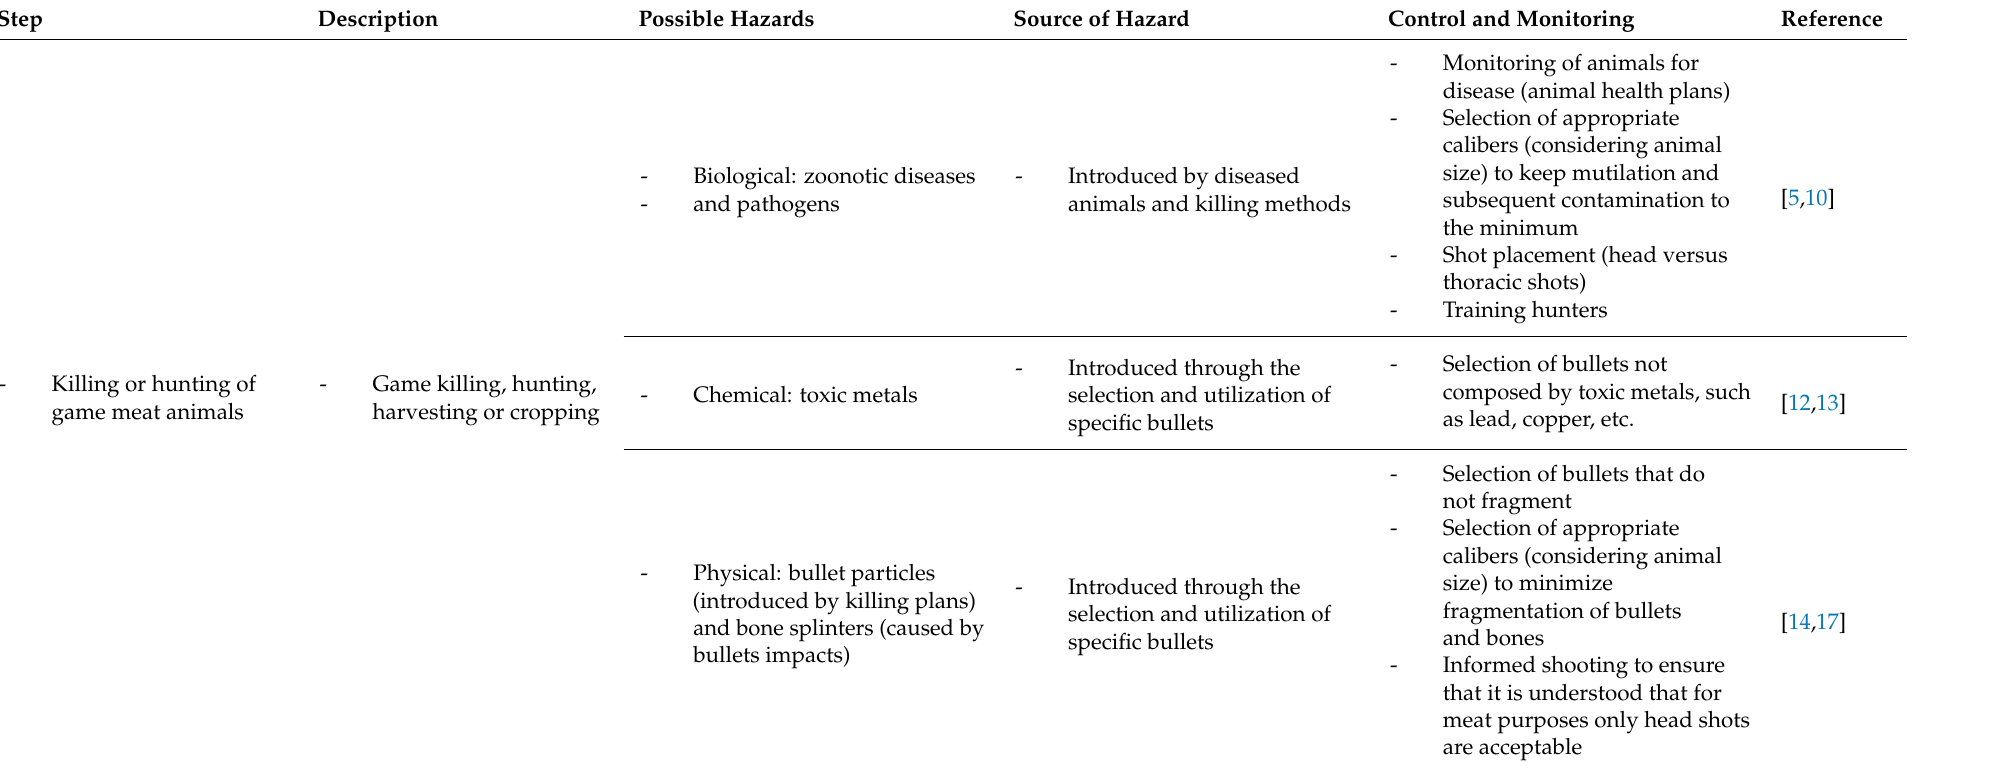
Table 1. Basic hazard identification and control plan for the slaughter of small wild ungulate animals from killing at a farm to after chilling at an